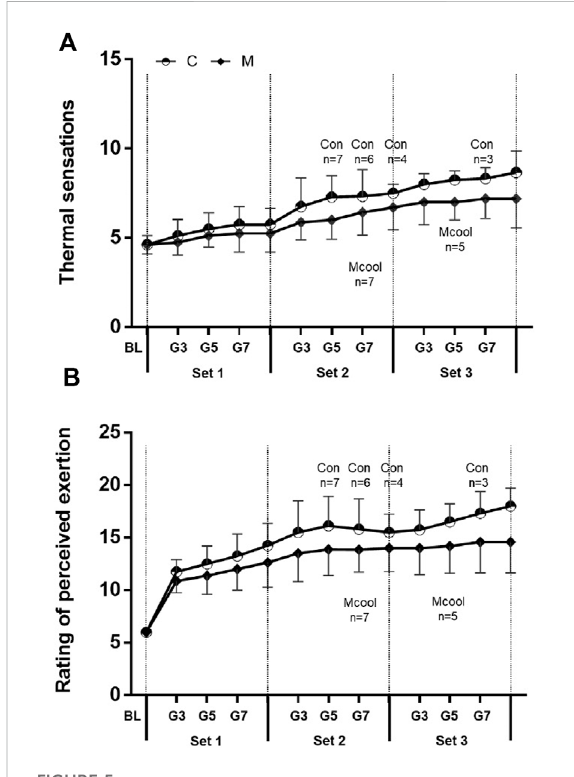
FIGURE 5 Thermal sensations (A) and rating of perceived exertion (B) over the entire simulated tennis match in CON and MCOOL conditions. Vertical lines denote the end of each “ set ” . Remaining participants ( n ) out of eight are indicated for each trial. All values are presented as Mean ± SD. M, mixed-cooling condition; C, control